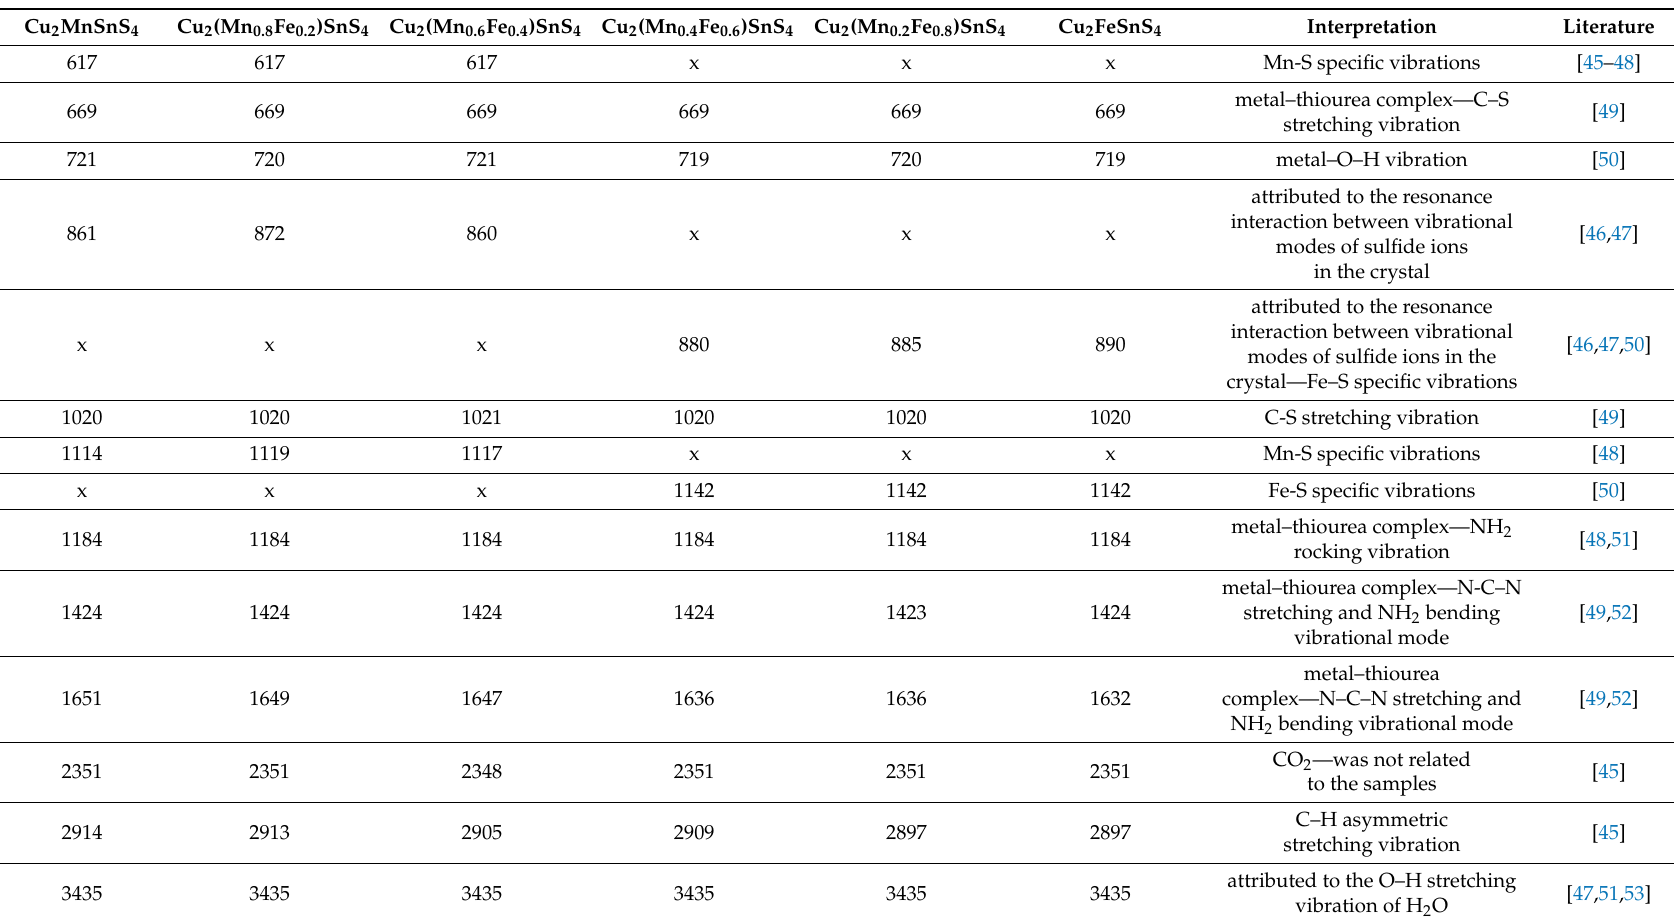
Table 2. Fourier transform infrared frequency range and functional groups of Cu 2 (Mn 1 − x Fe x )SnS 4 solid solution